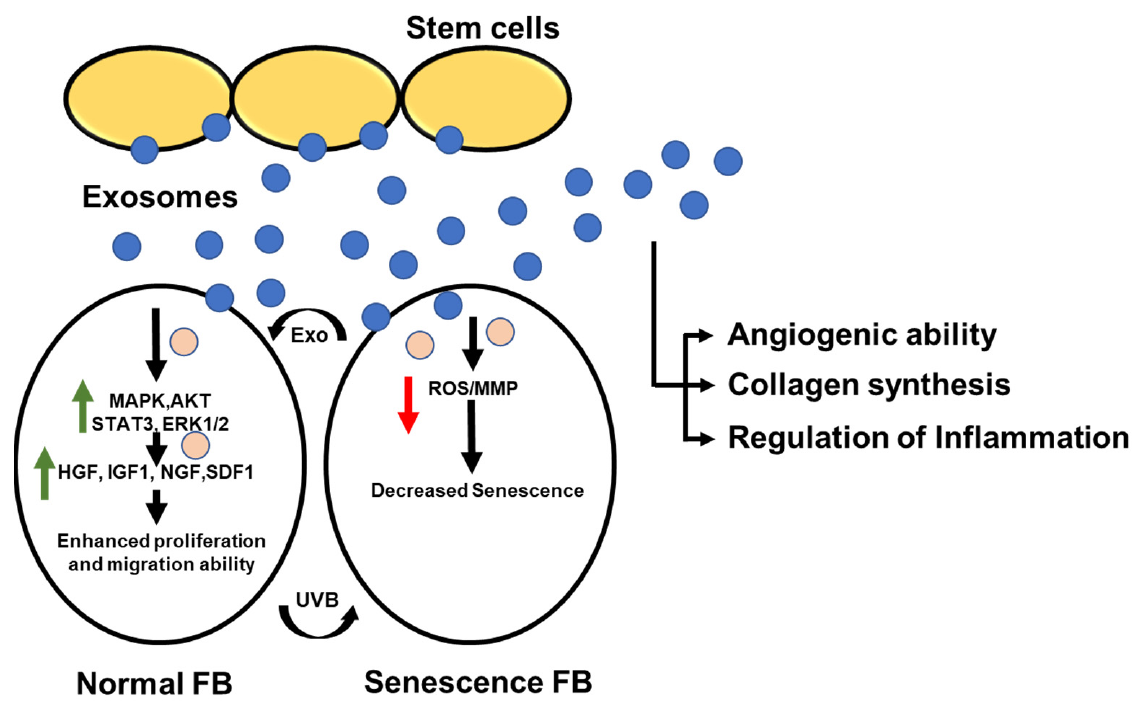
Figure 5. Stem cell derived exosomes enhance the proliferation and migration of skin fibroblast. Exosomes from stem cells are shown to enhance proliferation and increase migration ability by increasing MAPK and AKT etc. in the case of normal fibroblast cells. However, in the case of senescence fibroblast (induced due to exposure to UVB), the same exosomes are found to decrease senescence. Stem cell exosomes are found to have an impact on angiogenic ability, collagen synthesis, and regulation of inflammation in skin disorders. The green up-arrow depicts increased expression, and the red colored down-arrow depicts decreased expression.